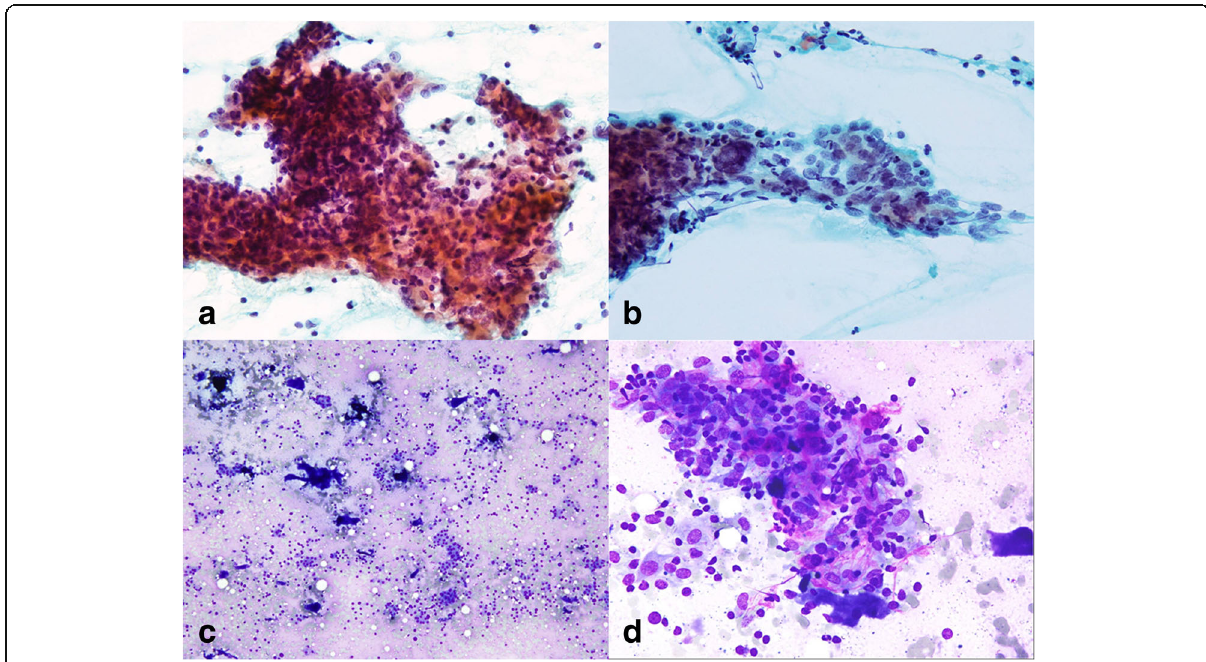
Fig. 2 FNAC of neck lymph node: three-dimensional and syncytial cellular fragments accompanied by small lymphocytes ( a . Papanicolaou, 400×); epithelioid cells with enlarged nuclei, vesicular chromatin, prominent nucleoli, and pleomorphic contours ( b . Papanicolaou, 400×). FNAC of the left thyroid: cohesive clusters of follicular epithelial cells and dense extracellular matrix. ( c . Liu, 100×); Few atypical epithelioid cells forming syncytial groups ( d . Liu, 400×)